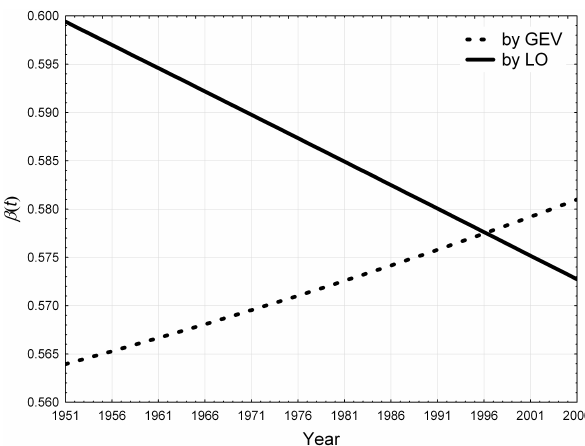
Fig. 7. Non-stationary β(t) by two